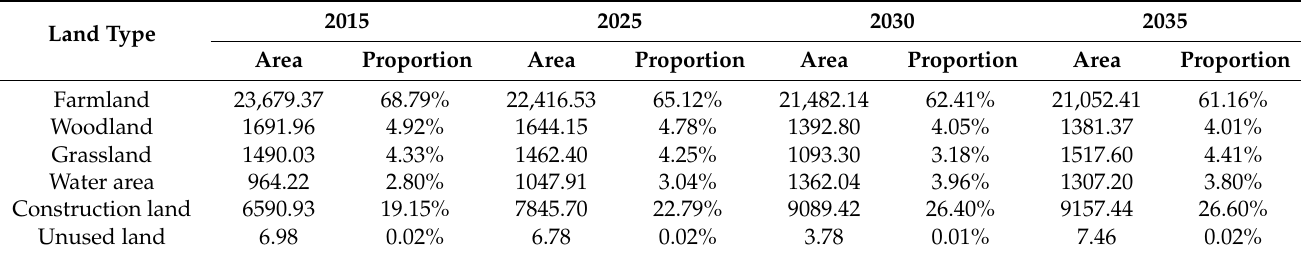
Figure 13. Land use forecast results for 2015, 2025, 2030, and 2035 (km²). Table 6. Land use change in 2015, 2025, 2030, and